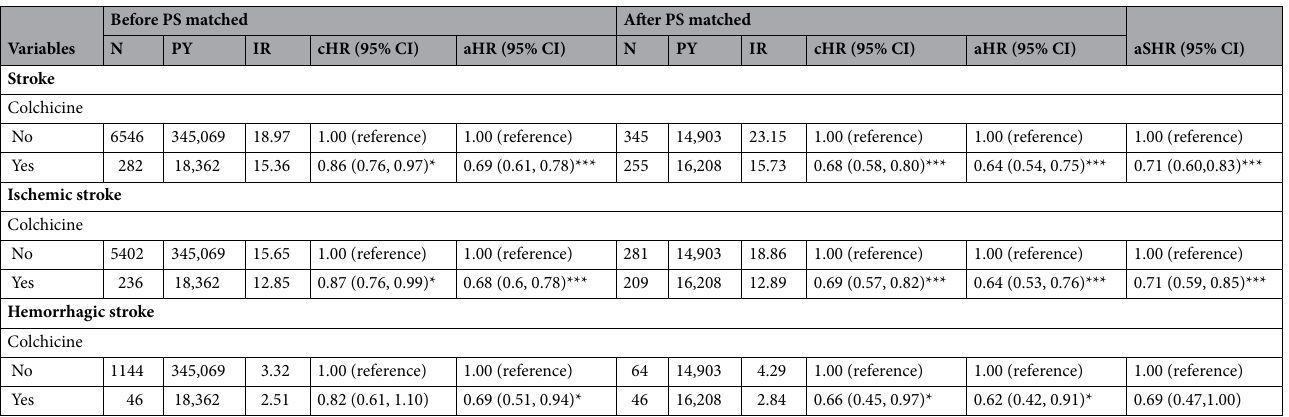
Table 6. Incidence and hazard ratios of stroke in DM patients without gout treated with and without Colchicine. aHR adjusted for age, sex, hypertension, hyperlipidemia, hypoglycemia, obesity, gout, pneumonia, hepatitis B, hepatitis C, liver cirrhosis, Allopurinol, Benzbromarone, nsaid, Oralsteroid, Antithrombotic, adapted Diabetes Complications Severity Index, aDCSI and inpatient day. PS, propensity score; N, number of event; PY, person-years; IR, incidence rate, per 1000 person-years; cHR, crude hazard ratio; aHR, adjusted hazard ratio; aSHR: adjusted subdistribution hazard ratio; CI, confidence interval. *p < 0.05, ***p <